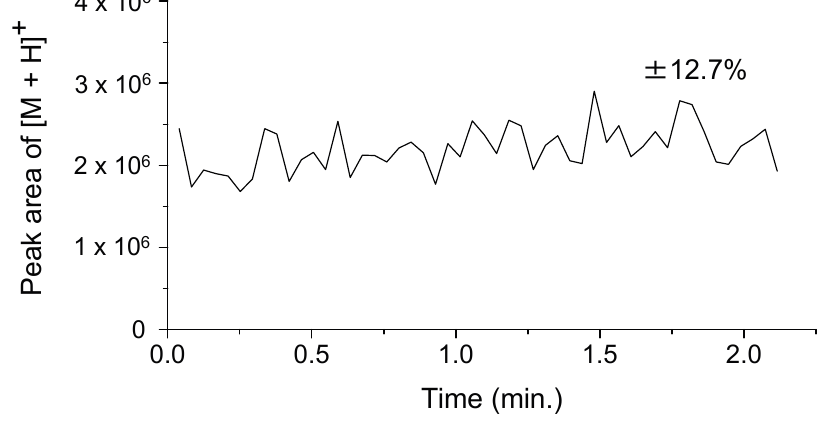
Figure 2. Extracted ion chromatogram of the protonated ion [M + H] + of angiotensin II. The wavelength of the DFG laser is set at 6.05 µm, and the pulse energy is 400 µJ. Each data point was extracted from the raw mass spectra, which were averaged from three micro-scans. The electric potential of the frit and the capillary temperature were set to 2.5 kV and 270 °C,